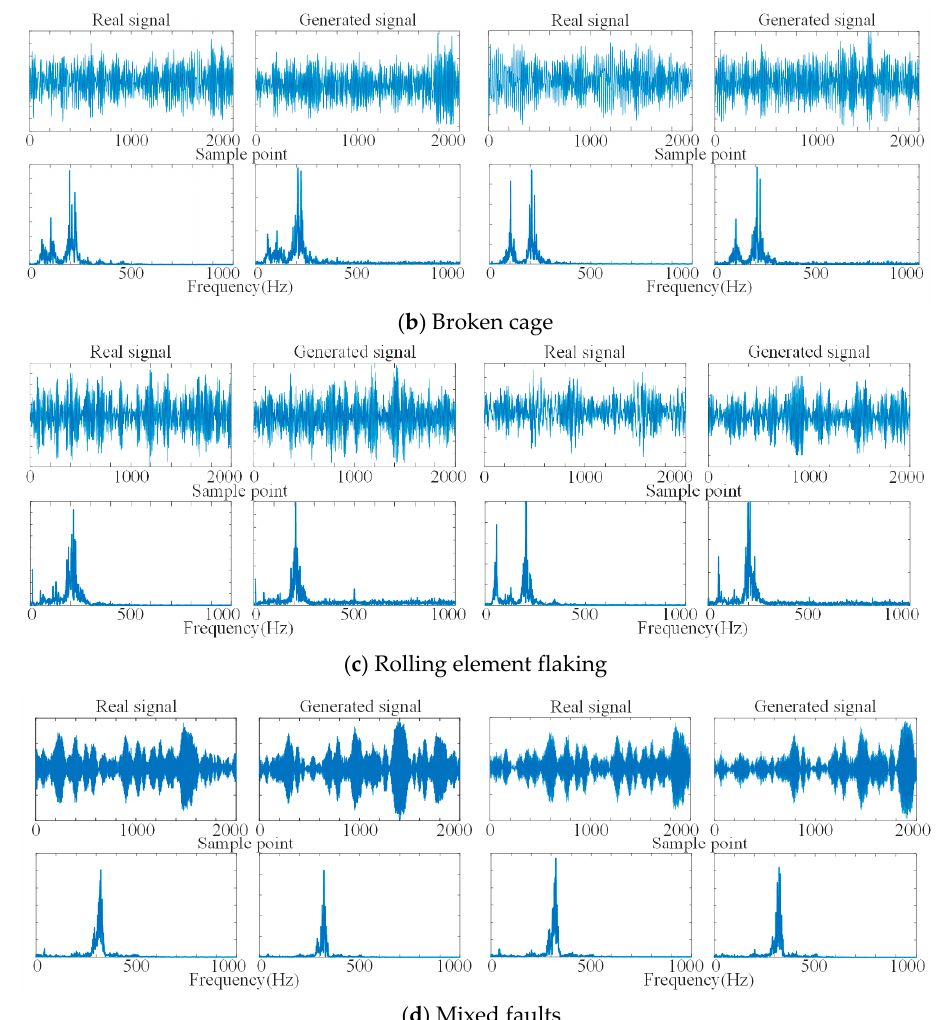
Figure 13. Comparison of time domain waveforms and frequency domain features of real and generated signals.